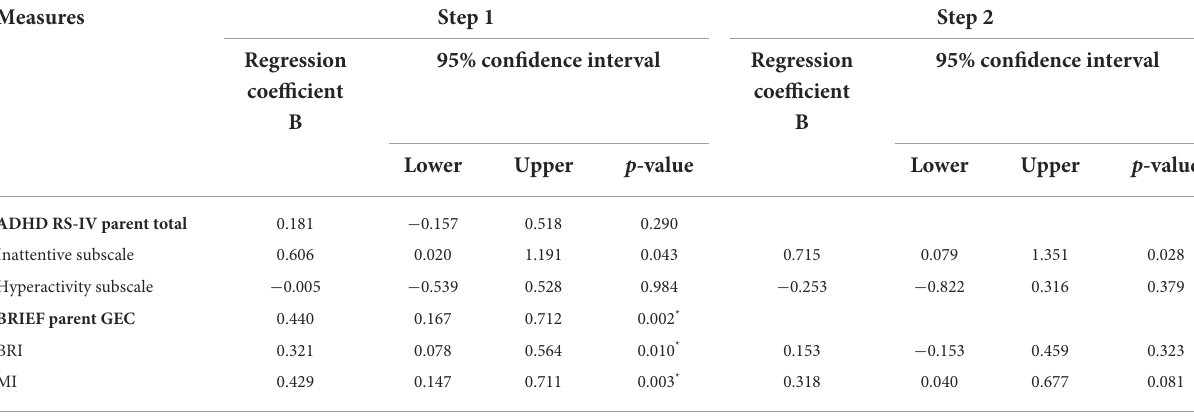
TABLE 2 Results from regression analysis using the parent-rated ADHD RS-IV, BRIEF and WFIRS measures as independent variables entered in two steps. Measures